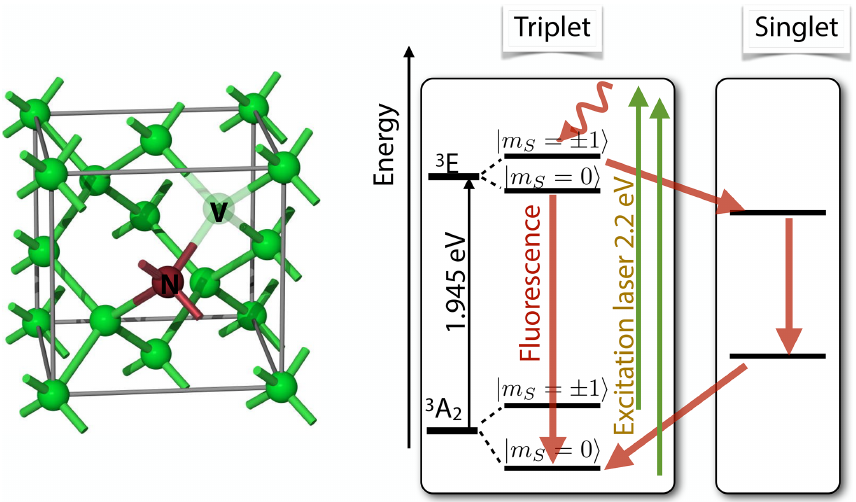
Figure 17. Structure of the nitrogen-vacancy (NV) defect centre in diamond and energy level system. Optical excitation results in spin- dependent ISC to the singlet state, which occurs predominantly for the m S = ± 1 states and therefore results in preferential population of the m S = state of the 3 A 2 ground